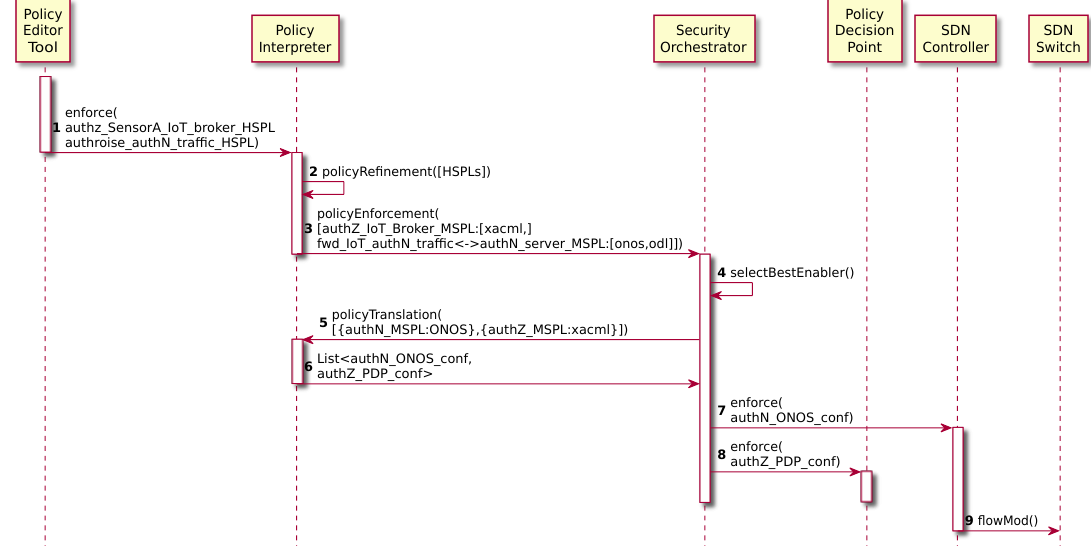
Figure 3. Authentication and Authorization proactive policy enforcement